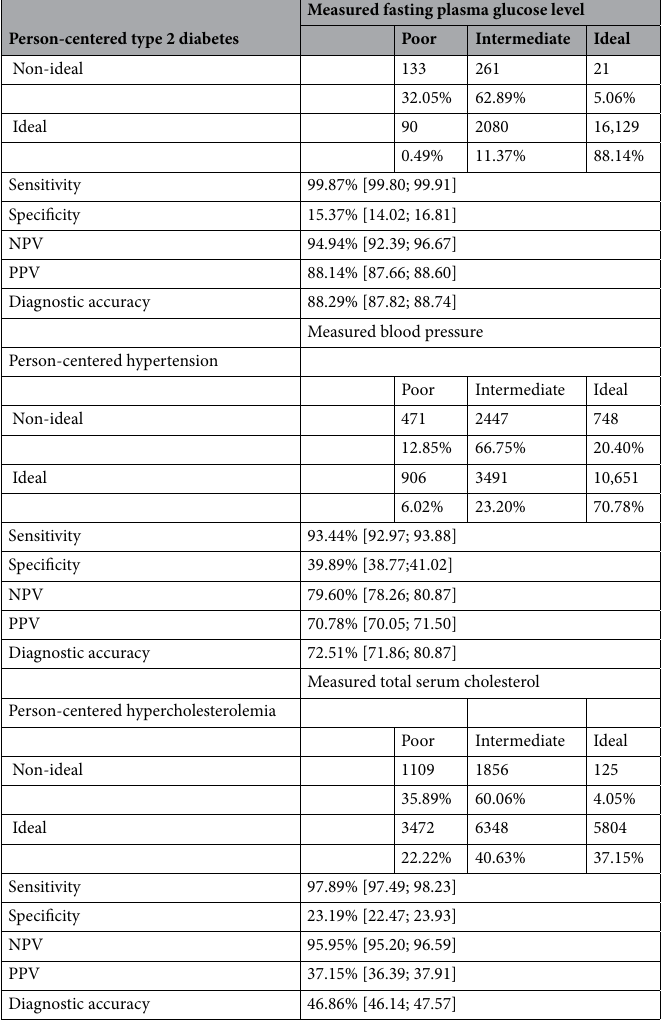
Table 4. Validity of person-centered and measured biological Life’s Simple 7 cardiovascular health metrics. PPV positive predictive value, NPV negative predictive value. Ideal level of measured fasting plasma glucose, blood pressure, and total serum cholesterol correspond to untreated fasting plasma glucose < 100 mg/dL, untreated systolic and diastolic blood pressure < 120/80 mmHg, and untreated total serum cholesterol < 200 mg/dL, respectively. Corresponding definitions for person-centered LS7 metrics are the absence of medication, treatment, or diagnosis for type 2 diabetes, hypertension, or hypercholesterolemia. Sensitivity, Specificity, NPV, PPV Statistics were computed for ideal and non-ideal levels of measured and person-centered LS7